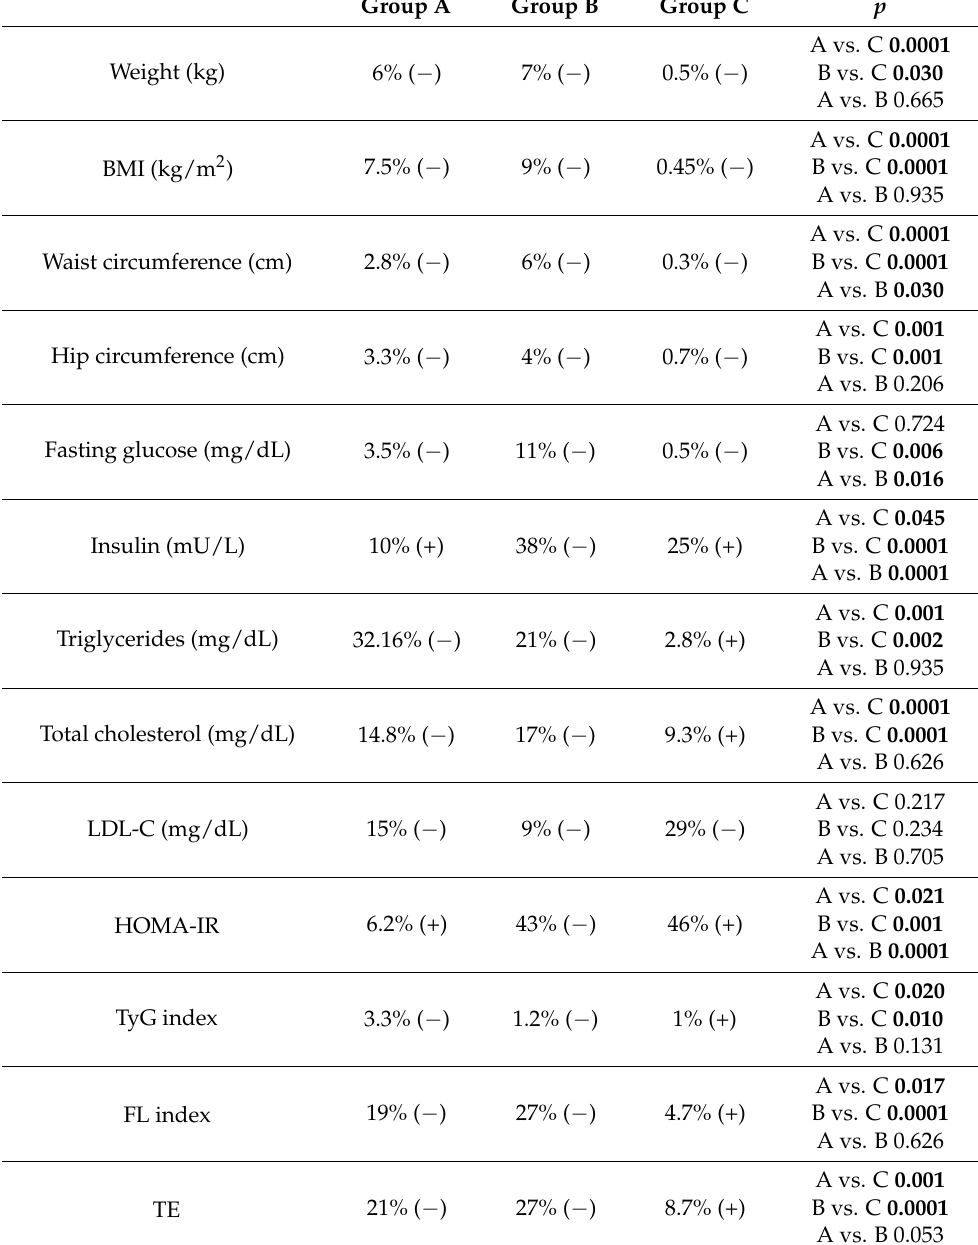
Table 5. Effects of diet and diet/BIL complex association on anthropometric, clinical and biochemical